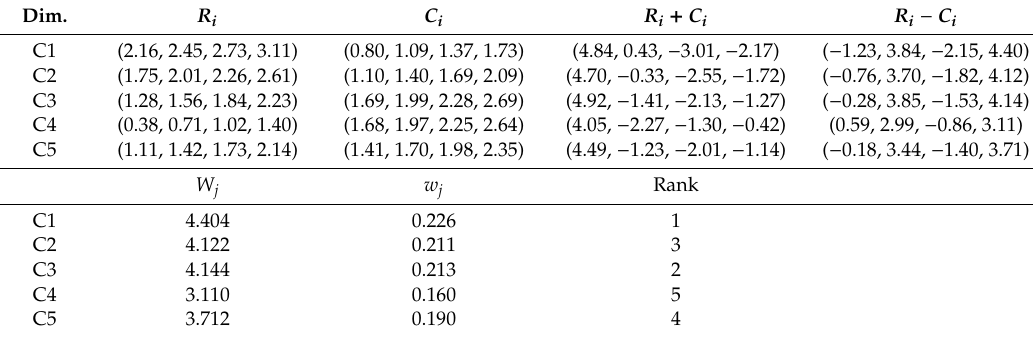
Table 8. Ranking the weight coe ffi cients of the